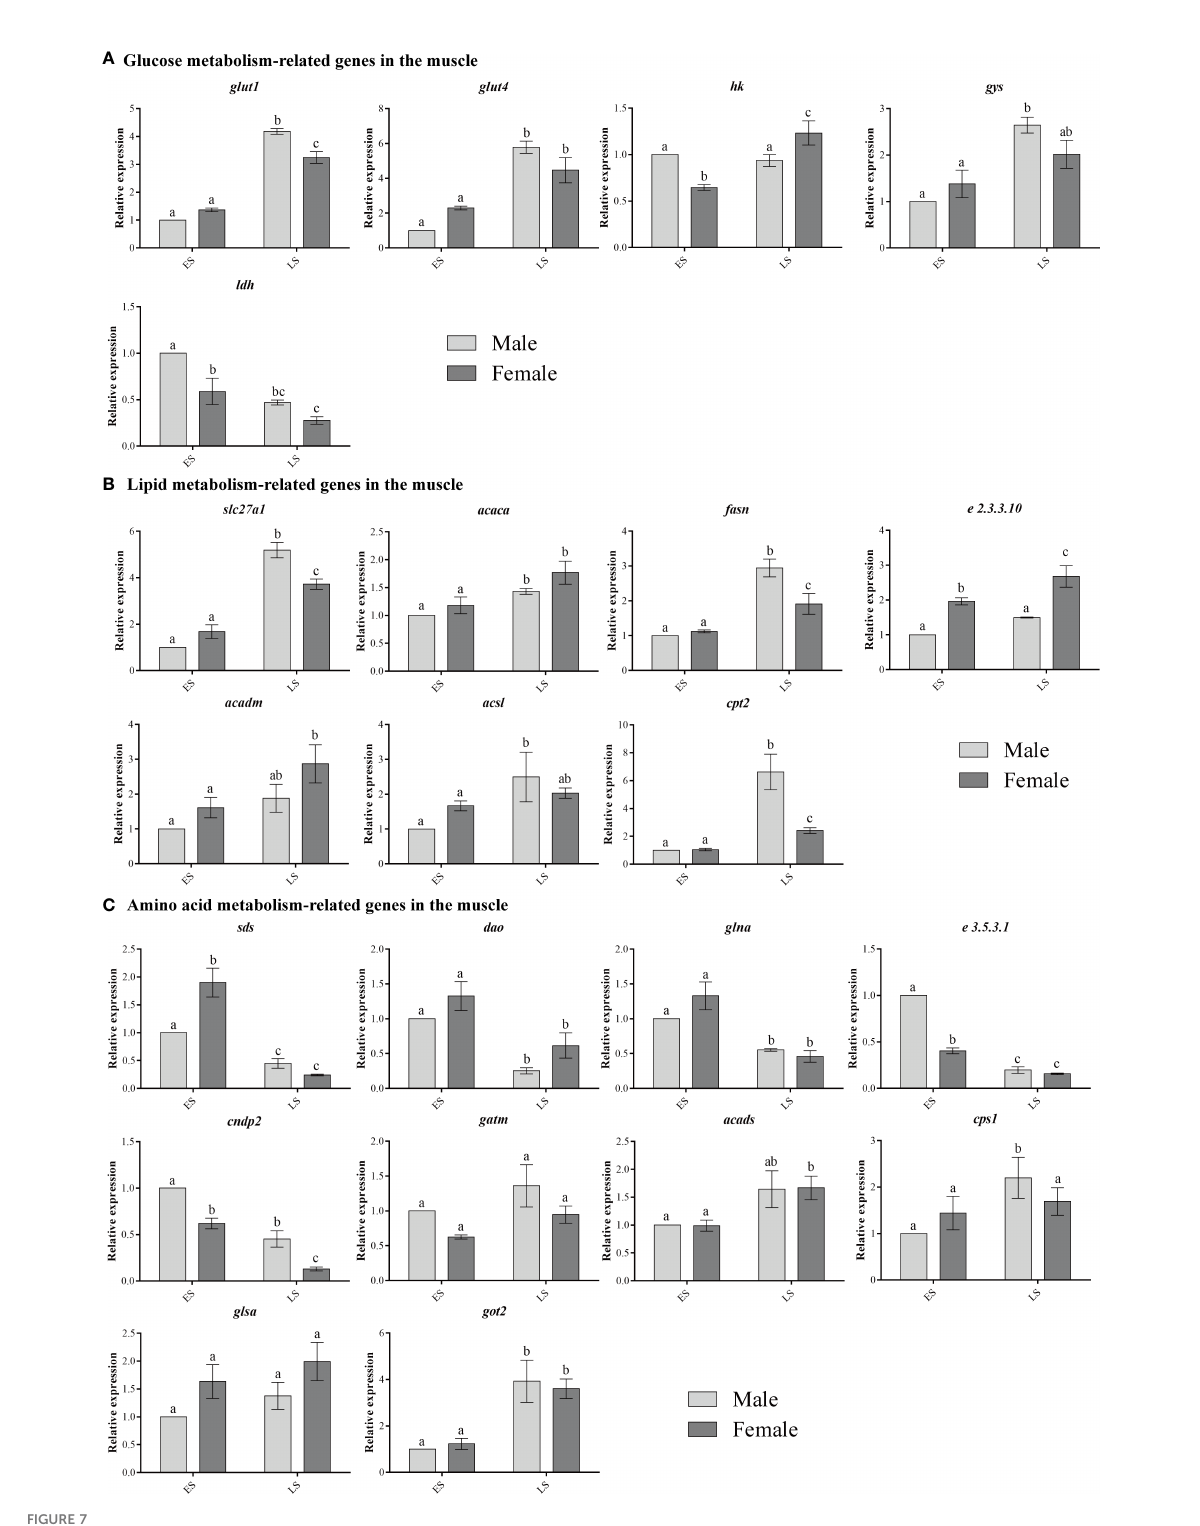
FIGURE 7 The expression of metabolism-related genes in the muscle. Different lowercase letters for the same sex in different stages and the different sexes in the same stage indicate signi fi cant differences (p <